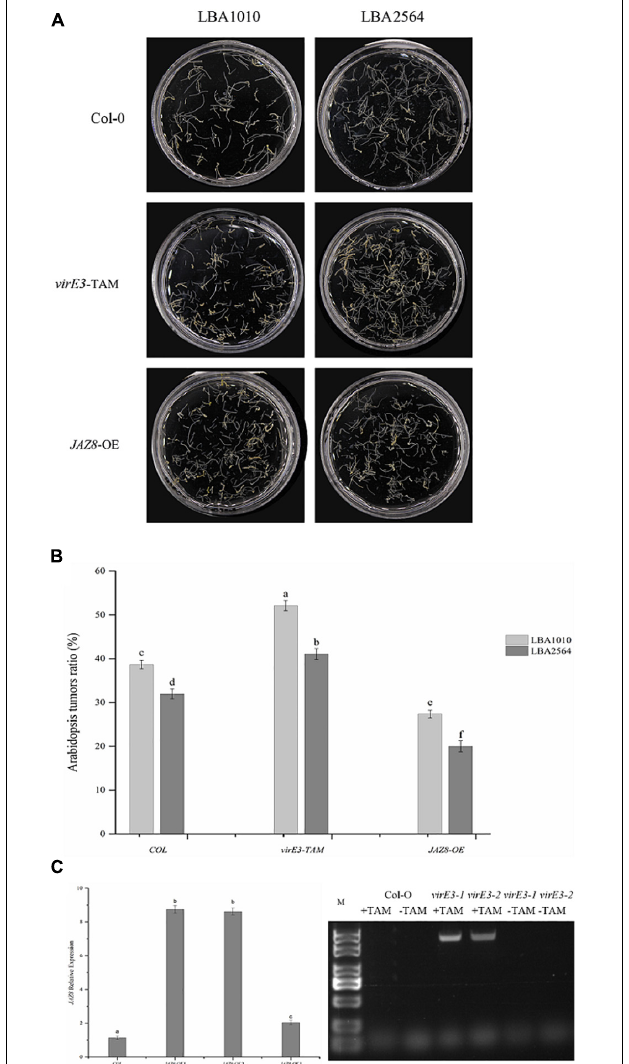
FIGURE 2 | Efficiency of Agrobacterium -mediated root transformation in virE3 and JAZ8 overexpressor lines ( virE3 -TAM and JAZ8 -OE lines) as compared with wild-type plants (Col-0) by Agrobacterium strain LBA1010 and virE3 deletion mutant LBA2564. (A) Tumors developed on root explants. Root segments of Columbia, virE3 -TAM1 and JAZ8 -OE1 lines were infected with tumorigenic Agrobacterium strain LBA1010 and its virE3 deletion mutant LBA2564. The root segments were photographed and scored 30 days after infection. (B) Quantification of the tumorigenicity showed in panel (A) . Error bars in B indicate SEM. Differences in tumorigenicity indicated by different letters are statistically significant ( P values < 0.05) and by the same letter are not statistically significant. (C) Gene expression analysis of JAZ8 and virE3 in transgenic over-expressor plant